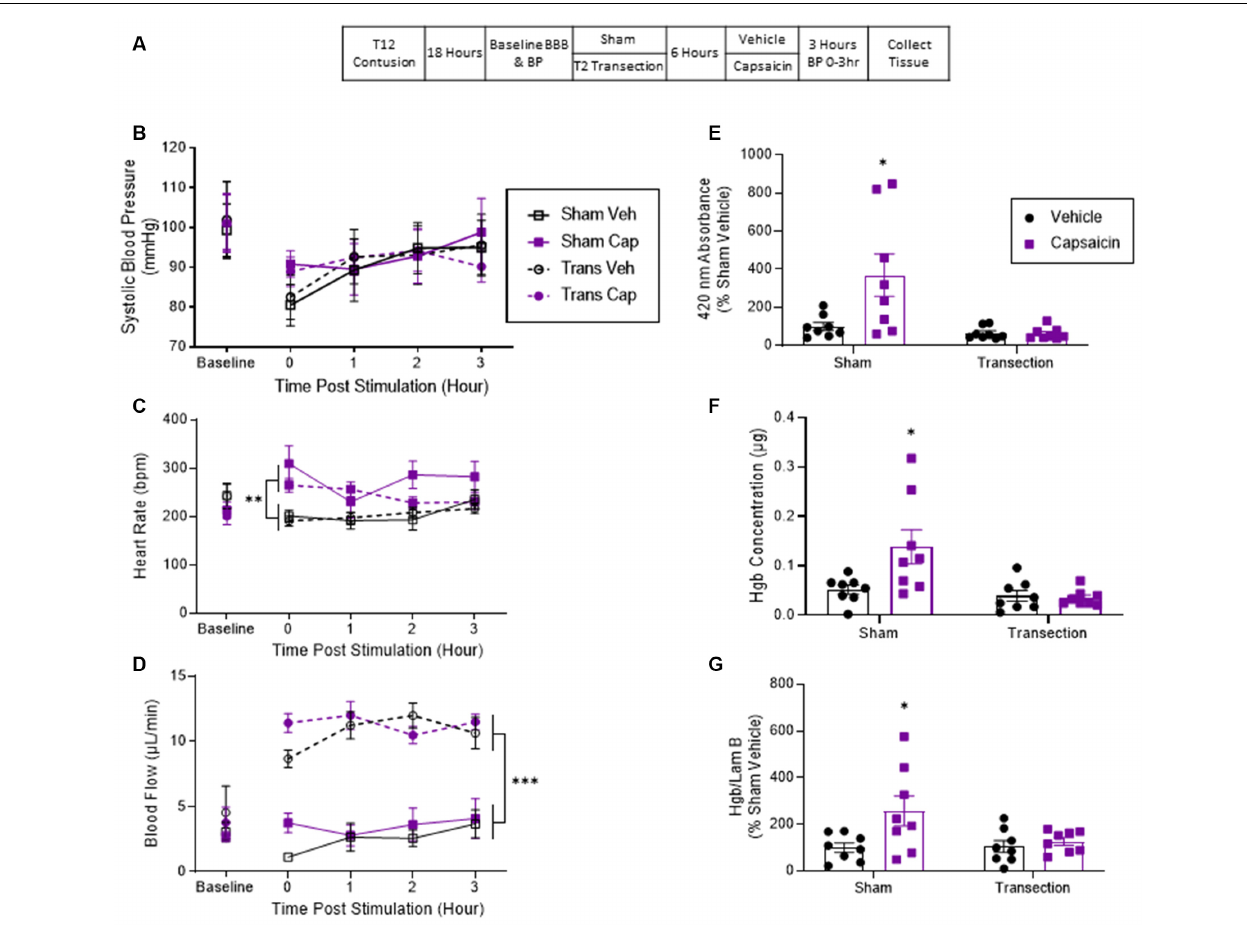
FIGURE 2 | Application of the irritant capsaicin to a hind paw increased hemorrhage after a lower thoracic contusion injury and this effect was blocked by a spinal transection. (A) Experimental design and timeline for experiment 2. (B) Application of capsaicin (Cap) to one hind paw did not induce a change in systolic blood pressure. (C) Capsaicin-treated rats exhibited a higher heart rate throughout the 3 h. (D) Only transected rats exhibited a significant rise in tail blood flow after capsaicin treatment. (E) Sham-operated rats that were treated with capsaicin exhibited greater absorbance at 420 nm for hemoglobin. Transection surgery blocked this effect. (F) Drabkin’s assay and western blot (G) showed similar results. Asterisks indicate statistical significance ( ∗ p < 0.05, ∗∗ p < 0.01, ∗∗∗ p < 0.001, n = 8). An asterisk placed over a group indicates that the group differs from all the others. Error bars represent the standard error of the mean